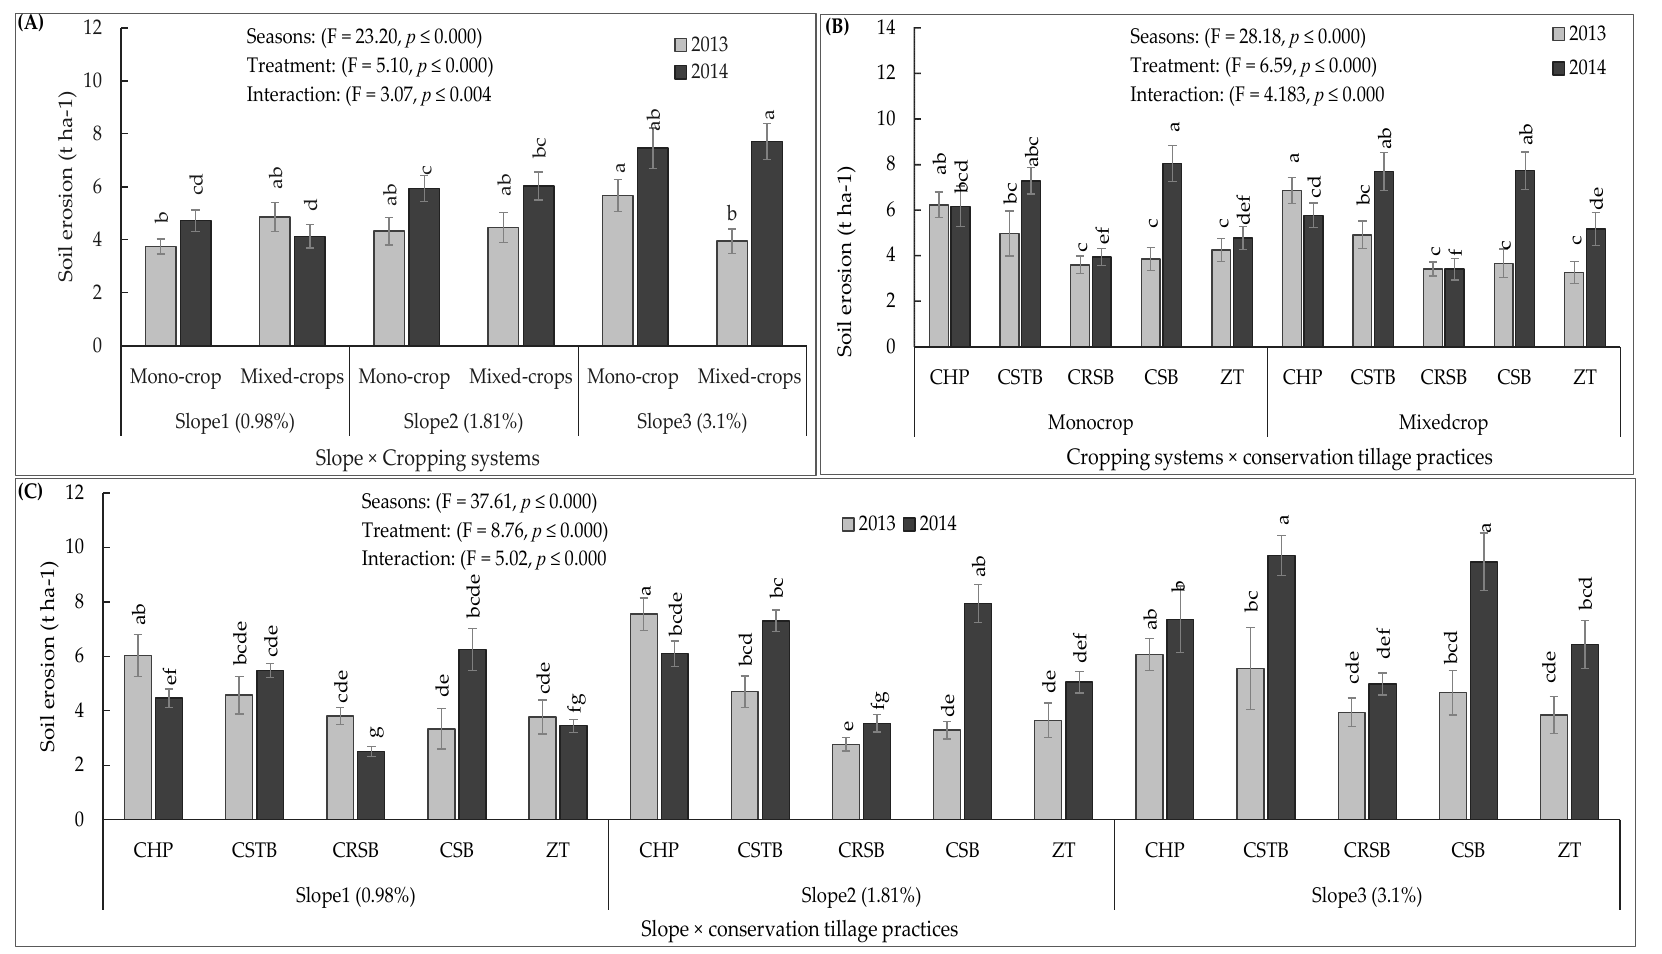
Figure 6. Interaction effects of (slope × cropping systems), (cropping systems conservation tillage practices), and (slope × cropping systems × conservation tillage practices) on eroded soil (t ha-1) for both seasons 2013 and 2014. Chisel ploughing, CHP; cross slope tied bonding, CSTB; contour ridge with stone bonds, CRSB; cross slope bonding, CSB; and zero tillage, ZT. Means followed by the different latter in same latter do not differ significantly at (LSD ; p ≤ 0.05).